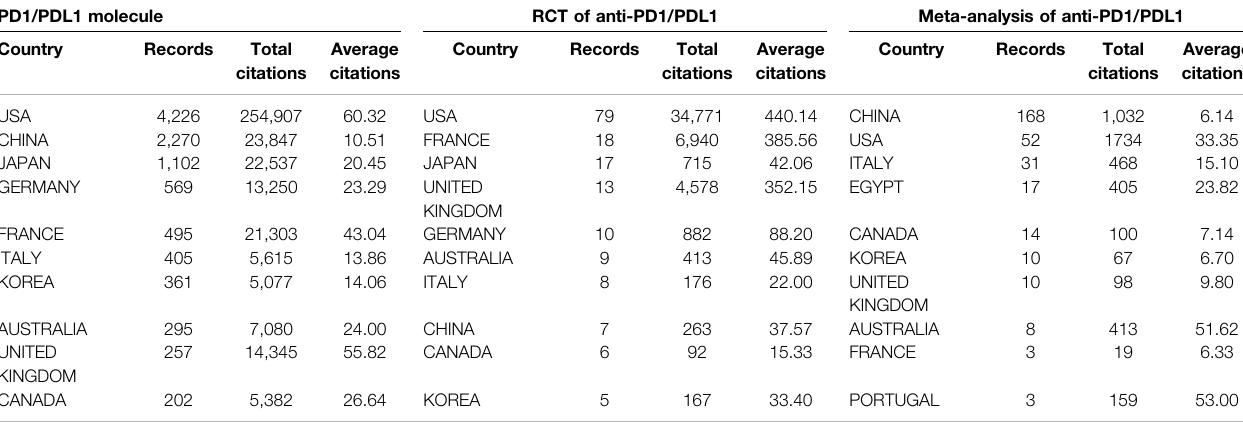
TABLE 2 | Top 10 productive countries and their total and average citations in three datasets. PD1/PDL1 molecule RCT of